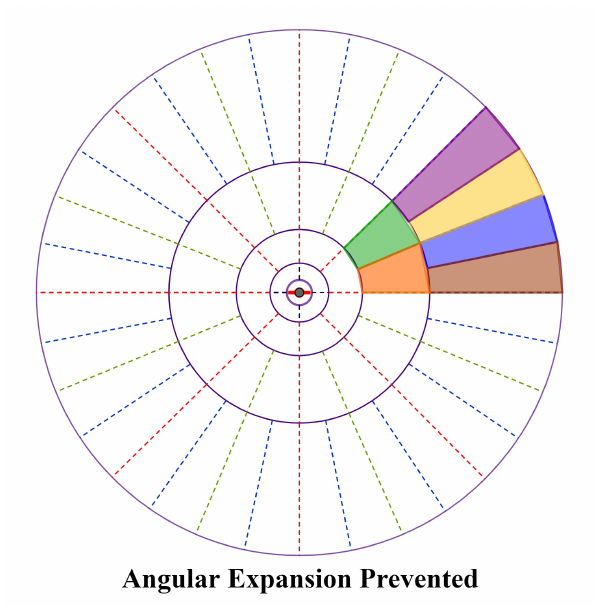
Figure 2. Refined discrete sampling grid (9) at j =